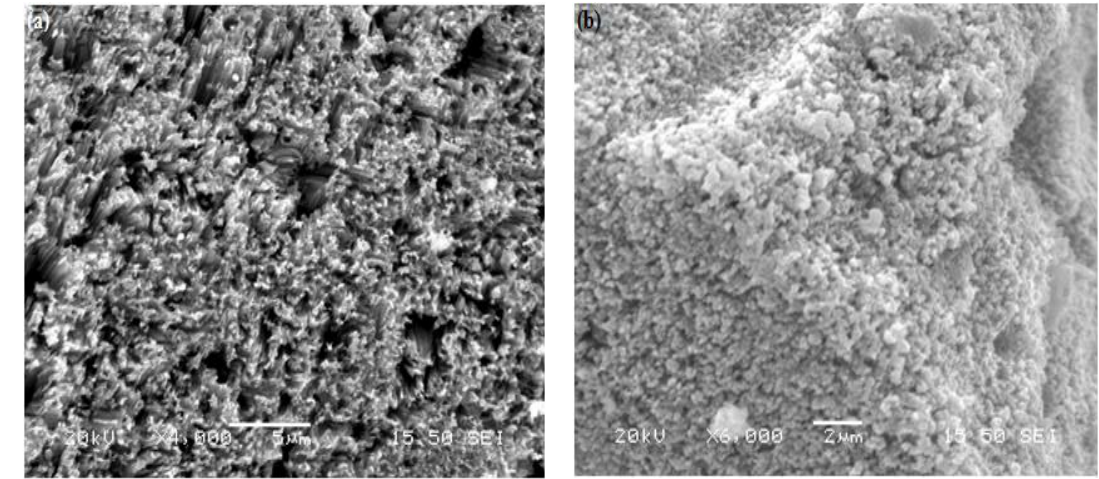
Figure 4. SEM images of recovered EoL PVP polycrystalline Si after etching and decorated with ( a ) Ag, ( b ) Cu.